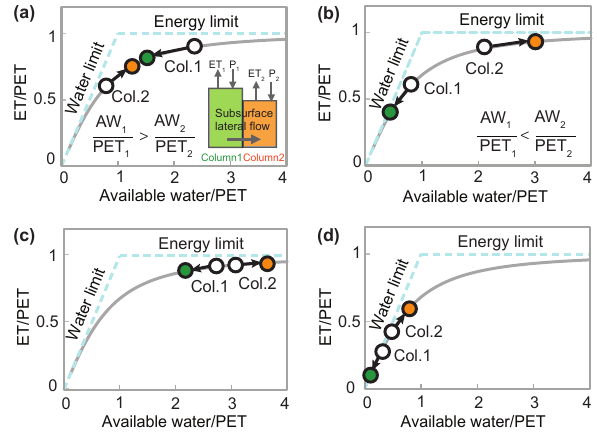
Figure 7. Four conceptual cases in a two-column model where Col- umn 1 is topographically always higher than Column 2 (water al- ways moves from Column 1 to Column 2). Open circles represent columns without lateral transfer and solid circles represent columns with lateral transfer. Depending on the columns’ wetness or dry- ness ( P and PET), lateral transfer can potentially (a) increase av- erage ET (the points representing Column 1 and Column 2 are pushed towards one another, spanning significant curvature in the ET function), (b) decrease average ET (points are pushed away from one another, spanning significant curvature in the ET func- tion), or (c, d) have little effect on average ET (the columns shift almost collinearly along the energy-limit or water-limit limbs of the